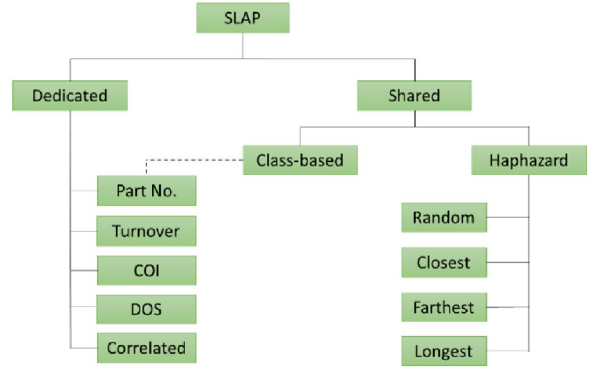
Fig. 2 Classification of storage